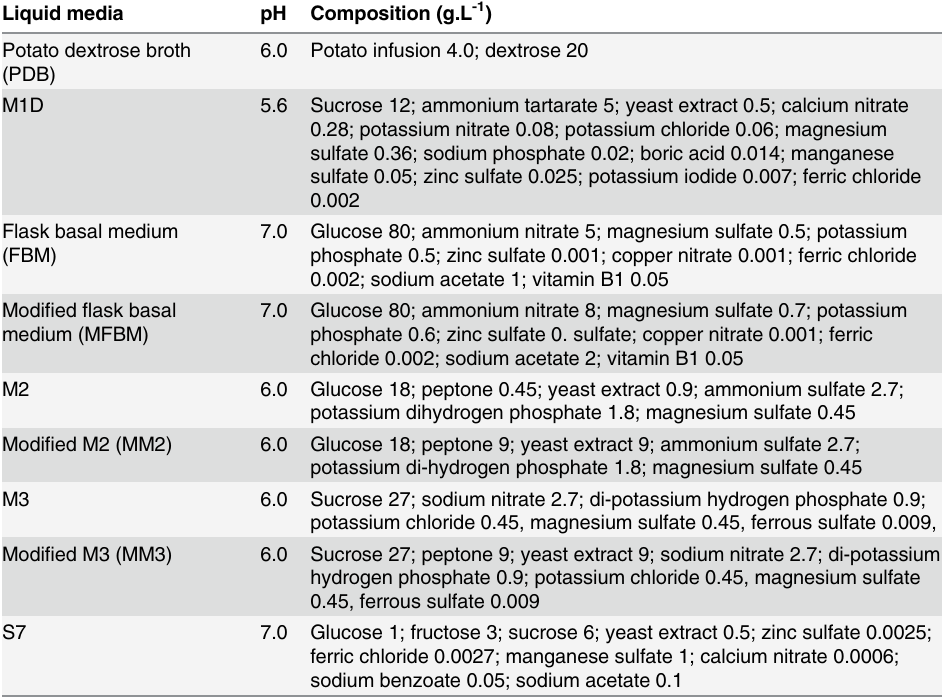
Table 1. Different media used for the optimization of fungal VCR and VBL